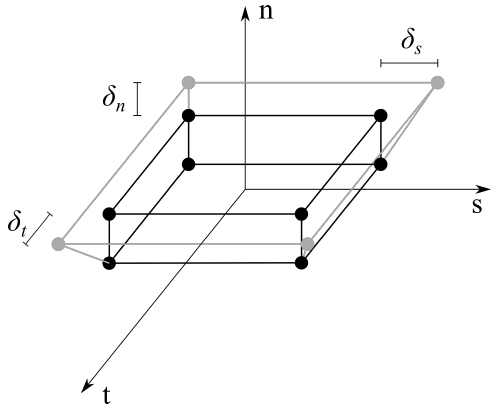
Figure 4. Cohesive element—local coordinate system and separations. The initial configuration is shown with black lines and the deformed one with grey